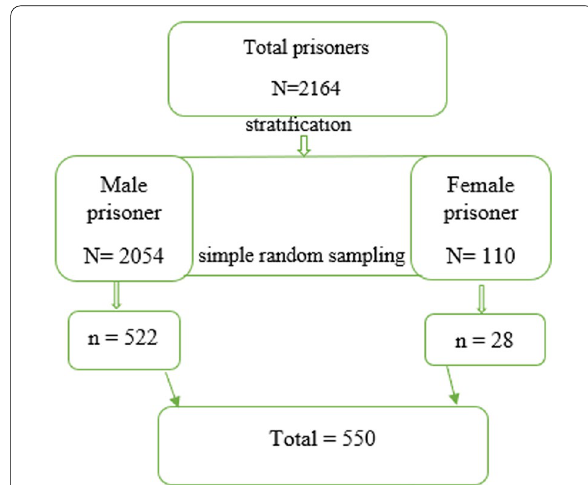
Fig. 1 Sampling procedure of study participant to assess Neisseria meningitidis carriage rate, antibiotic susceptibility profile, and associated factors among prisoners at Jimma Town, Southwestern Ethiopia in